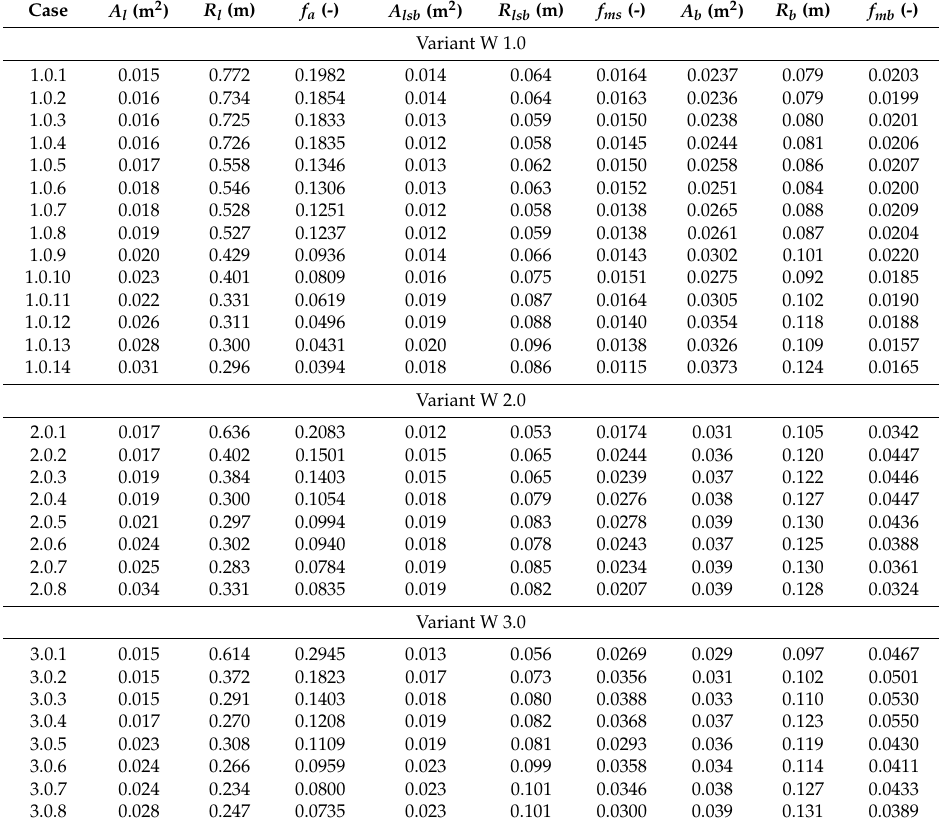
Table 2. Cross-section areas A i for sections of the wetted perimeter with a constant roughness, hydraulic radius R i and flow resistance coefficients in the cross-section of the main channel determined on the basis of the